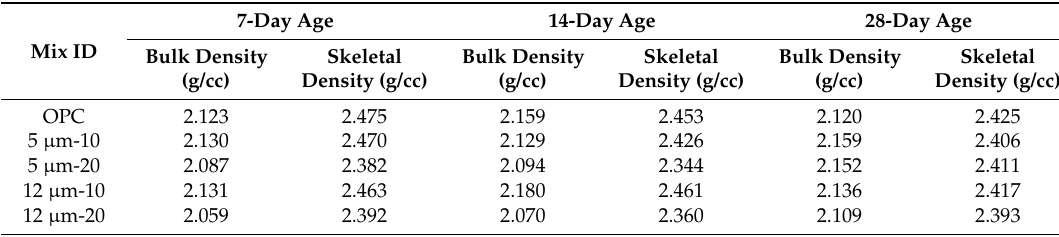
Table 2. Bulk and skeletal densities obtained through MIP.